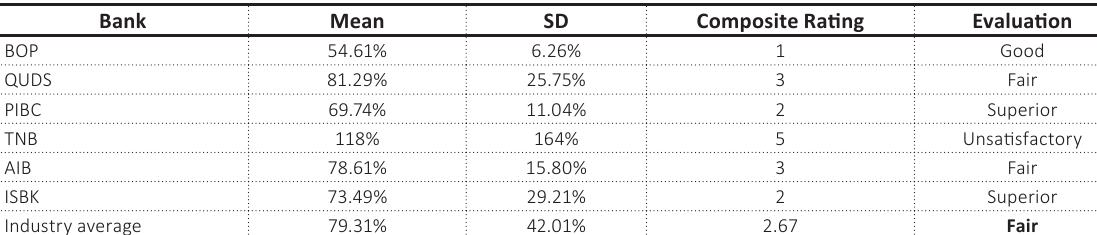
Figure 3. Operational efficiency ratio of listed banks (2007–2017) Table 7. Operating expenses to operating income (2007-2017)